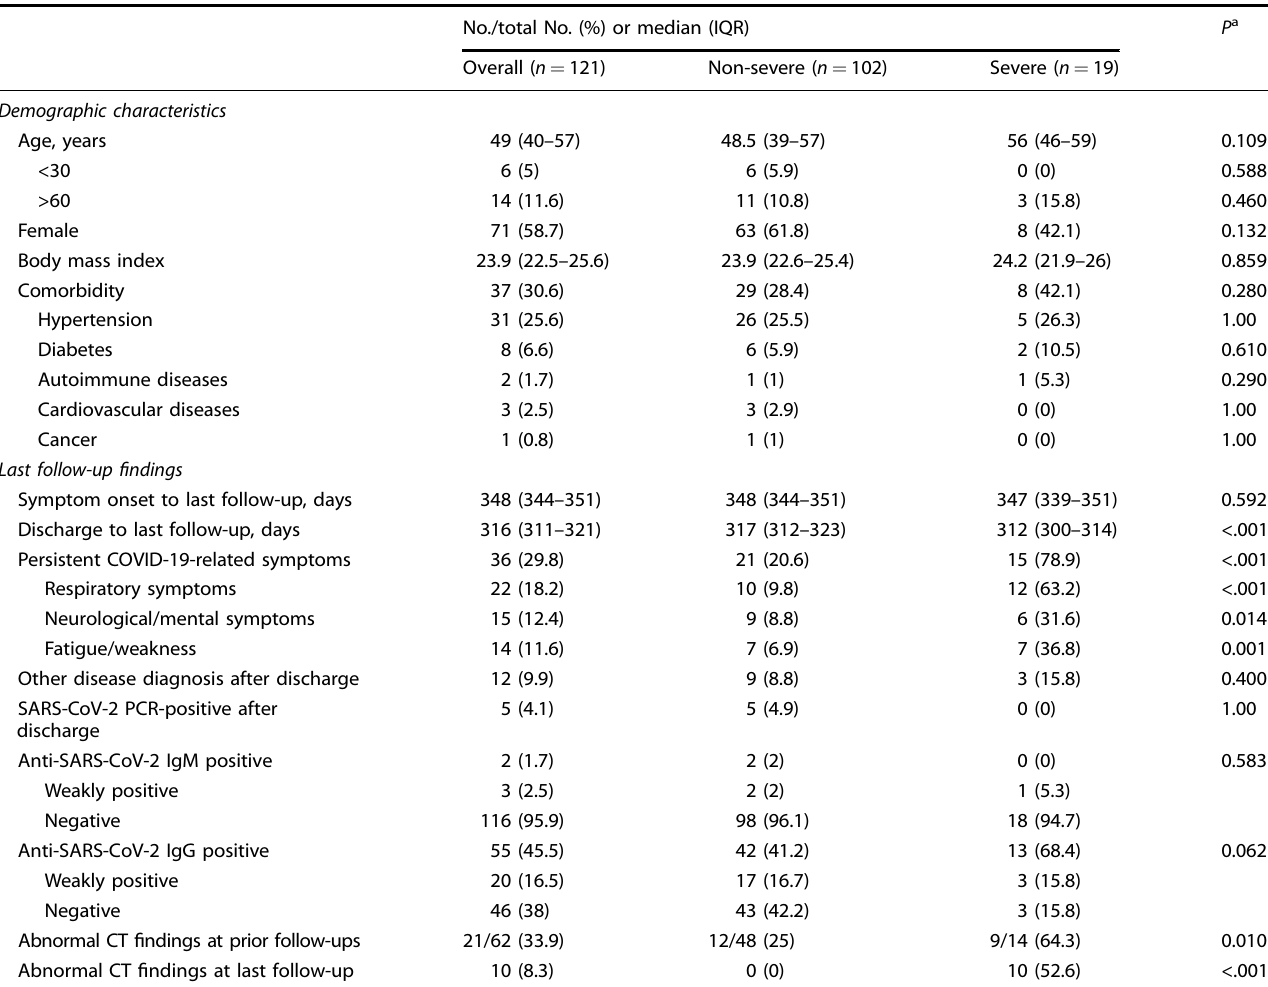
Table 1. Characteristics of participants by COVID-19